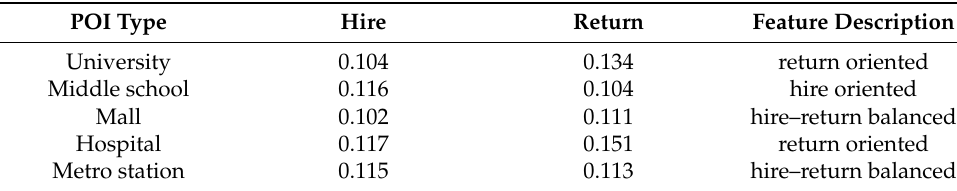
Table 1. Peak hour factors for different types of